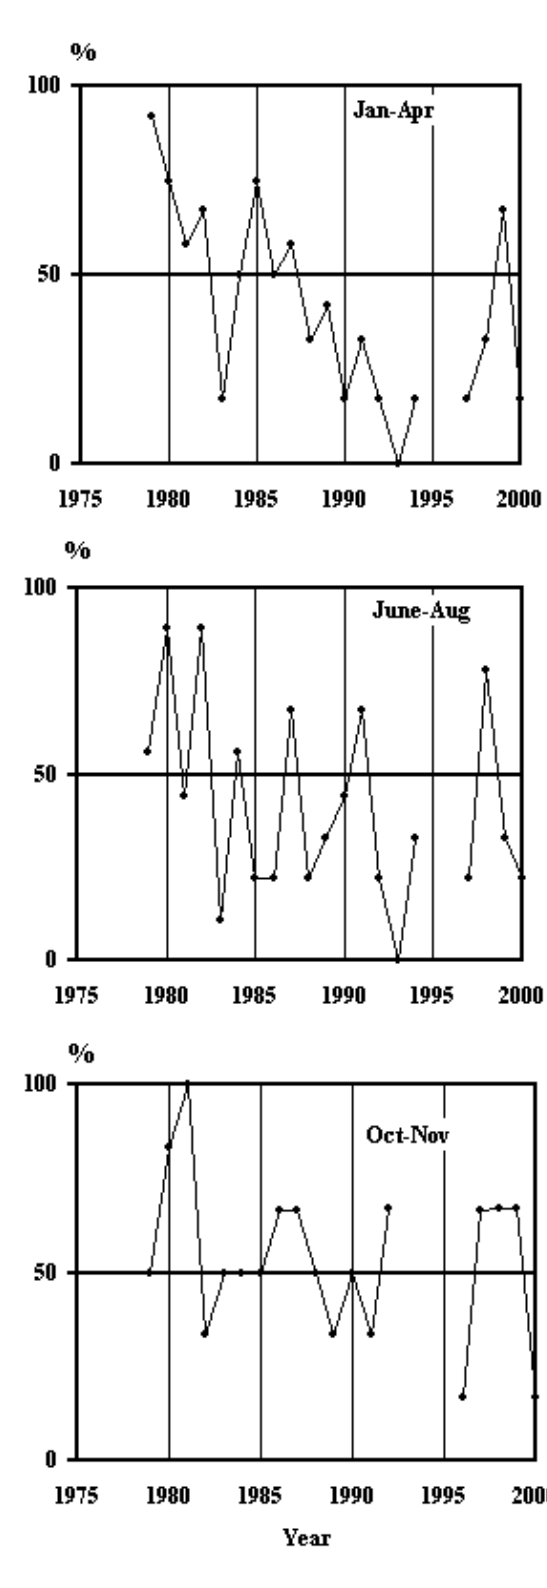
Fig. 8. Percent of positive deviations of the yearly ten-day mean values of total ozone from the long-term mean in the different sea-